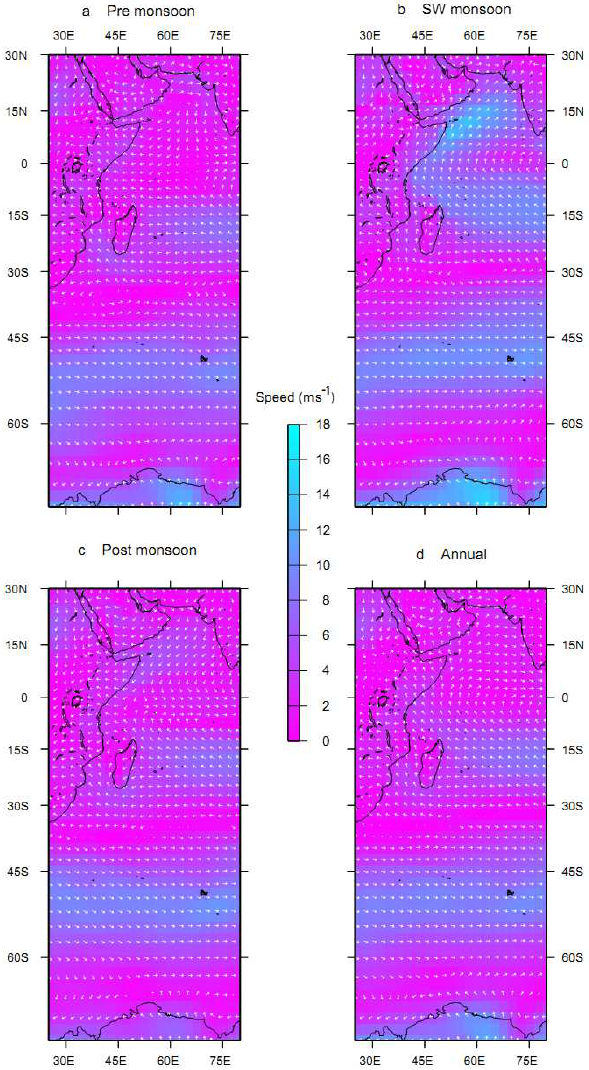
Fig. 7. Southern Ocean and Indian Ocean wind systems during 1 and 2 August showing the propagation of the storm from west to propagation of storm from west to east. 492